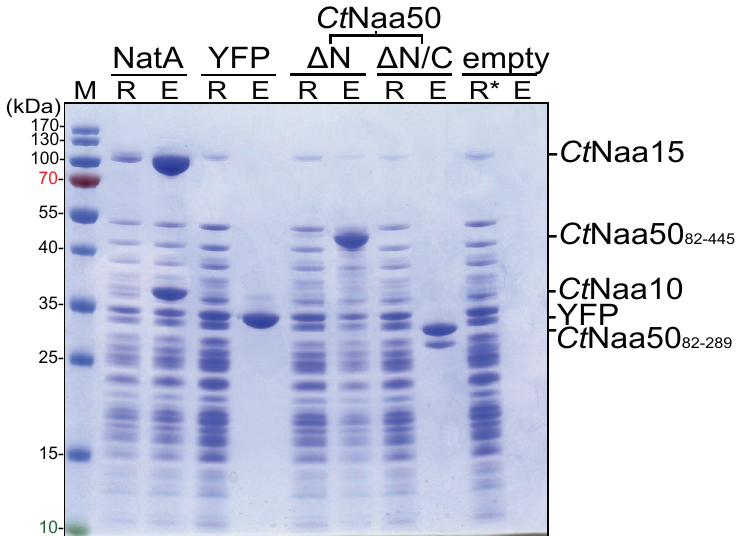
Figure 10. Ct Naa50 coelutes with Ct 80S ribosomes via its C-terminus. In a Flag-tag pull-down experiment, Flag-tagged proteins were eluted (E) from Flag beads after incubation with Ct 80S ribosomes (R; ribosome flow-through). The negative controls YFP and empty beads do not bind ribosomes. Ct NatA and Ct Naa50 82-445 ( ∆ N) coelute with ribosomes, while Ct Naa50 82-289 ( ∆ N/C) does not bind to the ribosome. M = Protein size marker; * highlights a pure ribosomal